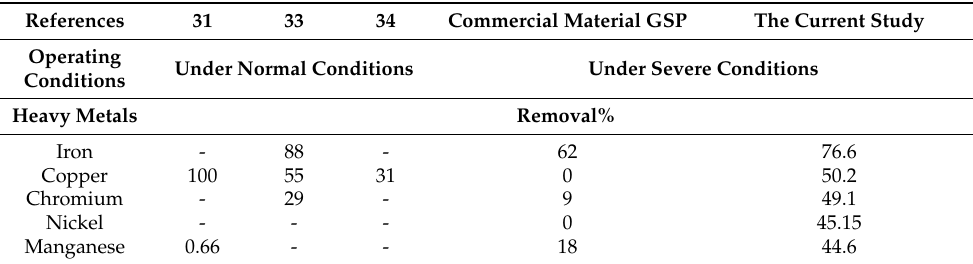
Table 3. Summary of the removal percentages of heavy metals using different samples reported in the literature in comparison with the structures designed in the current